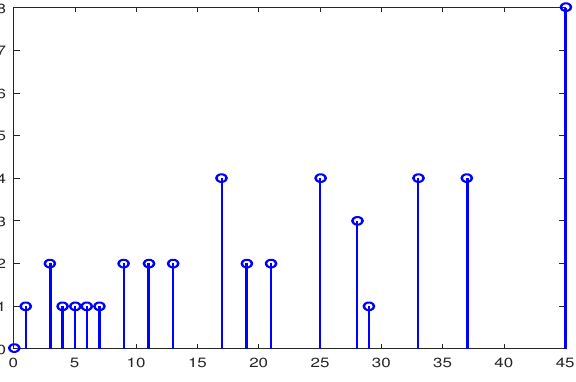
Figure 11. The dynamic event-triggering release instants and release intervals.